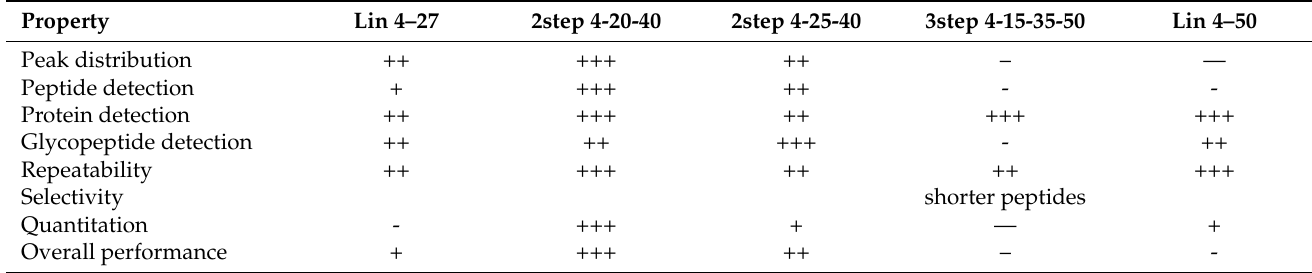
Table 4. Overall evaluation of the gradient programs presented. (+++ means best, — means worst performance characteristics, relative to the other